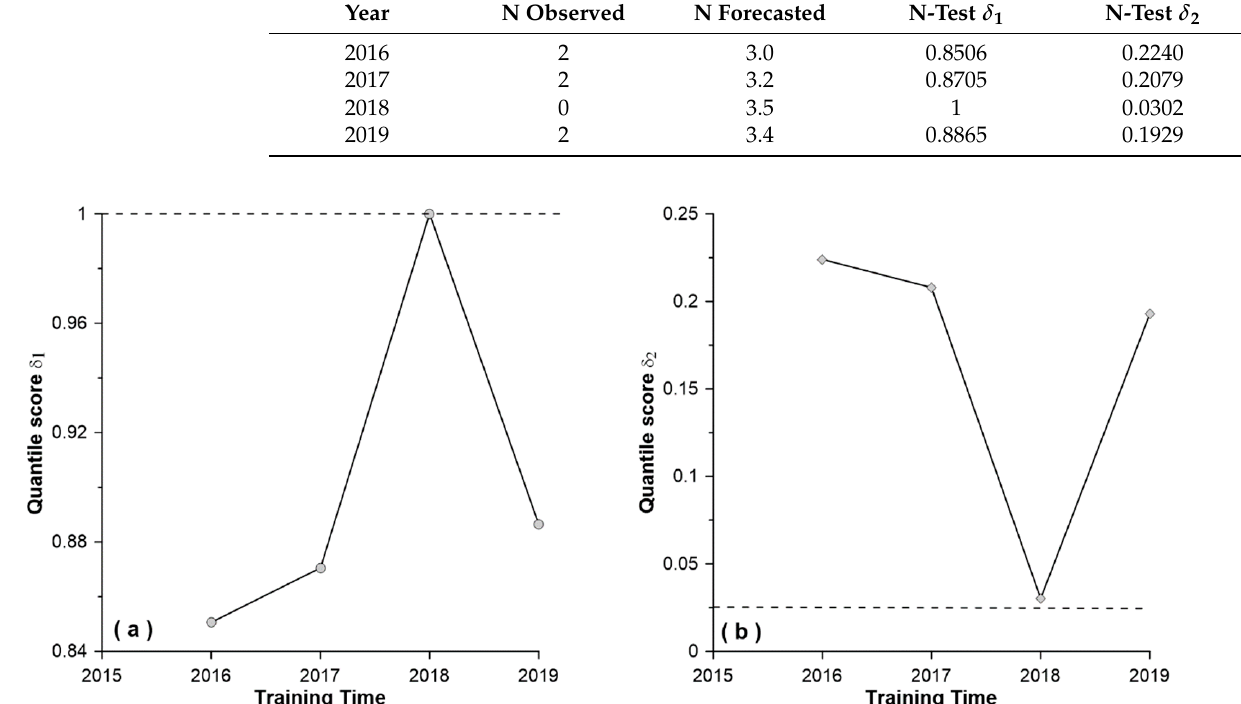
Figure 11. N-test values for ( a ) δ 1 index and ( b ) δ 2 index.